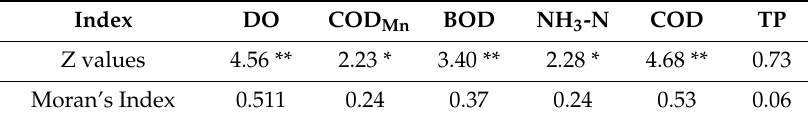
Table 2. Z values of Global Moran’s I spatial autocorrelation of the